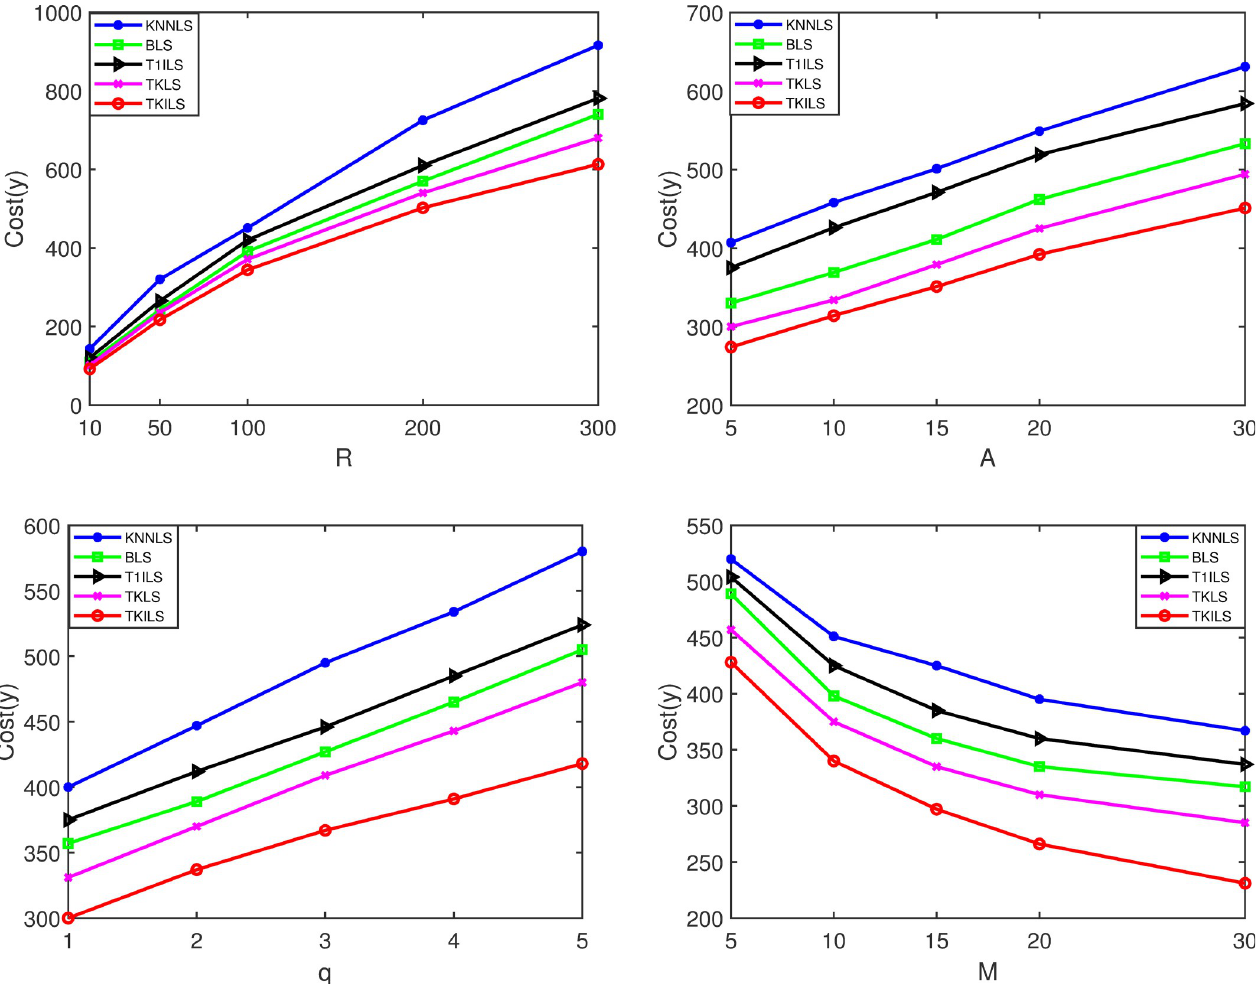
Fig 8. Cost results on the synthetic datasets. Note: Fig 8(A)–8(D) are the cost results for varying | R |, | A |, | q | and | M |, on the synthetic datasets, respectively.